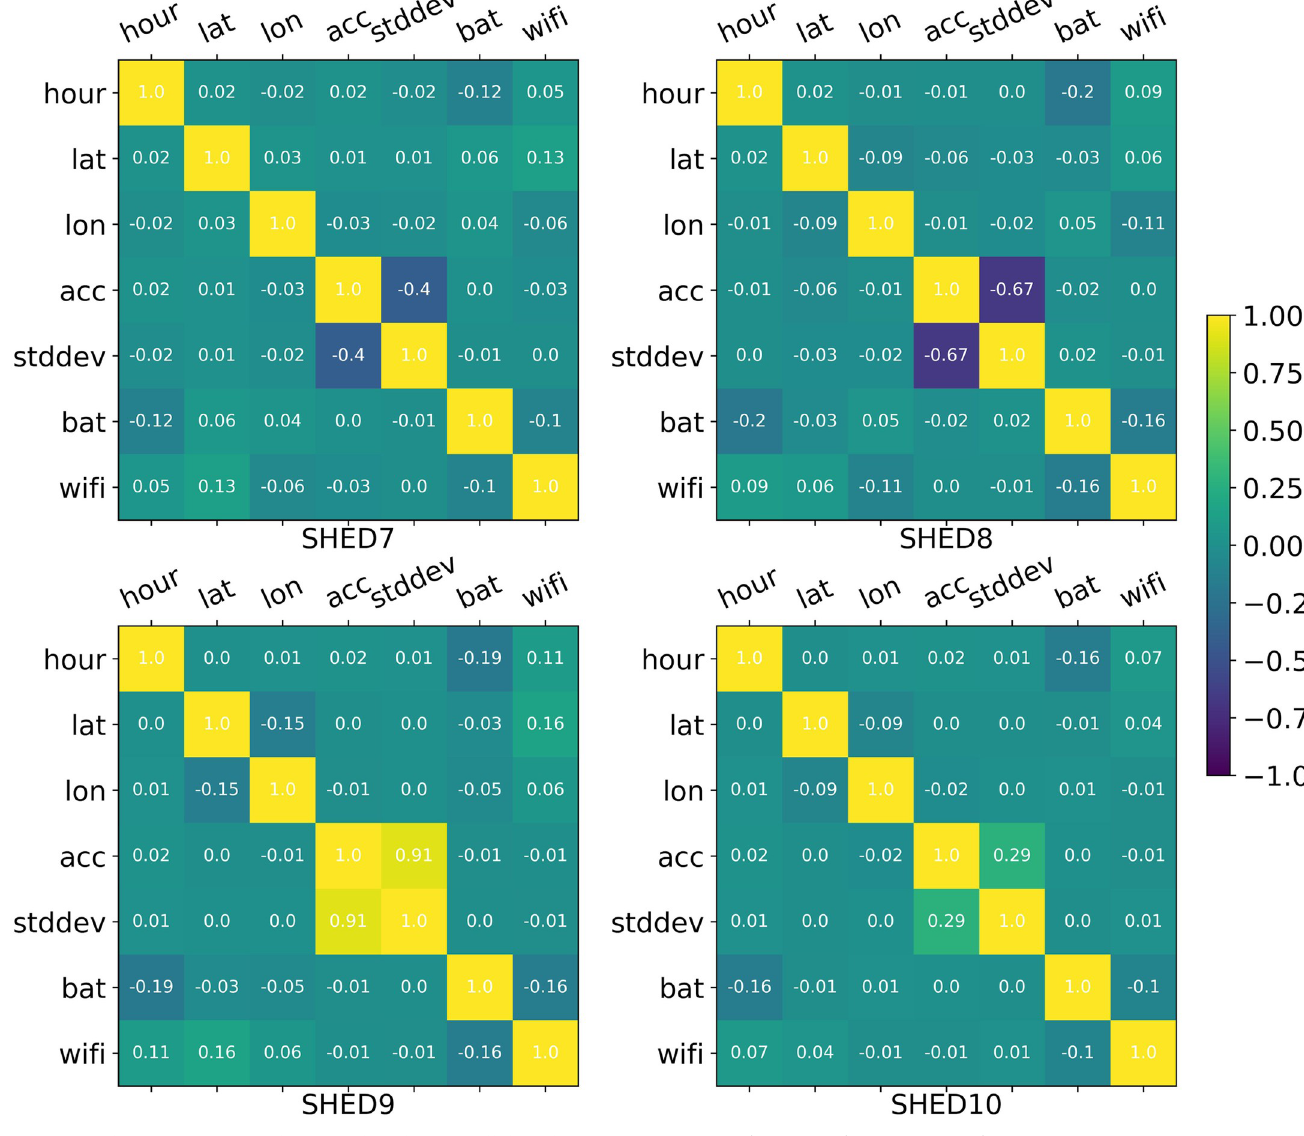
Fig 8. Correlation Matrix. Correlation analyses between all the 7 dimensions. Strong correlations are closer to 1 or -1 values.